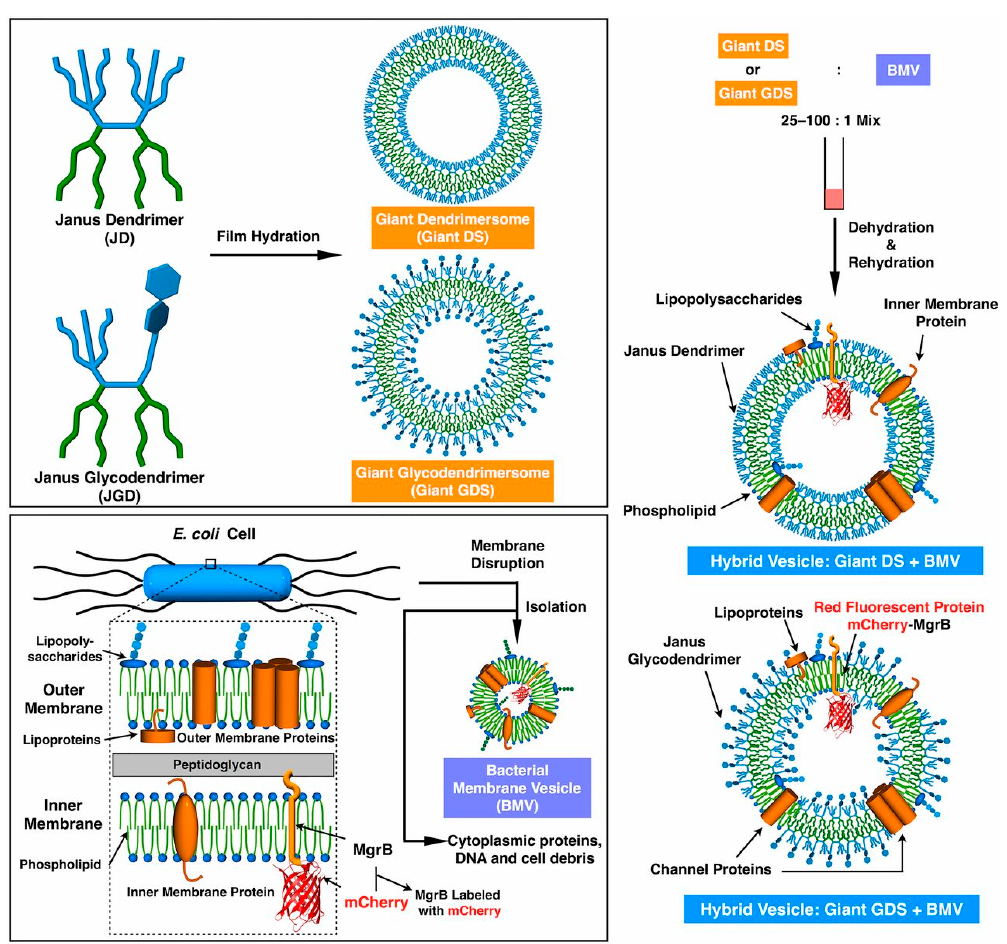
Figure 17. Preparation and coassembly of hybrid giant vesicles from giant DSs, giant GDSs, and E. coli BMVs enriched with the transmembrane protein MgrB tagged with the red fluorescent protein mCherry (mCherry–MgrB). Reprinted from [74]. (mCherry–MgrB). Reprinted from